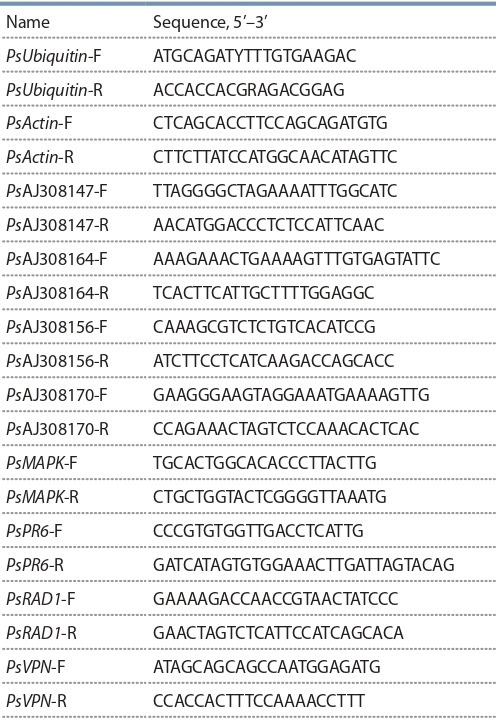
 Constructed primers used for qPCRNote: Melting point (Тm) for every primer was 54 °C.